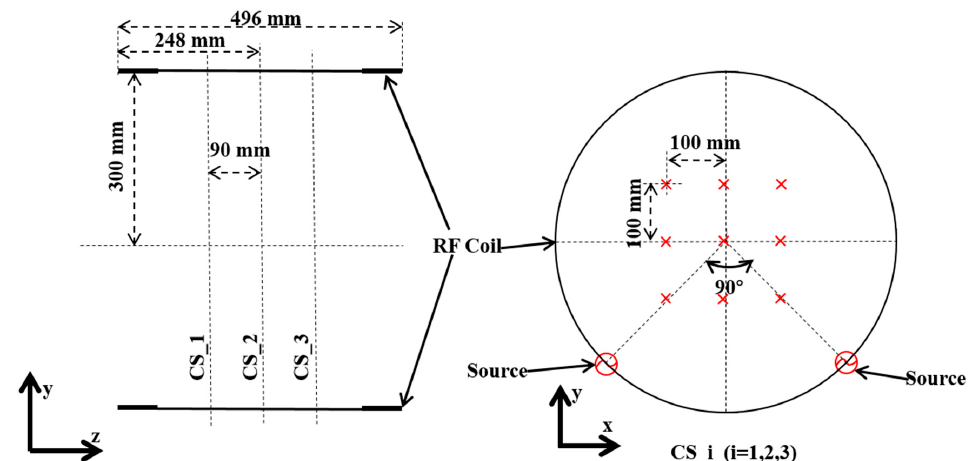
Figure 4. Field measurement for the Tx coil. CS_i (i = 1, 2, 3) indicates the three measurement surfaces in the coil, which were separated by 90 mm. “x” indicates the position of the measurement point.